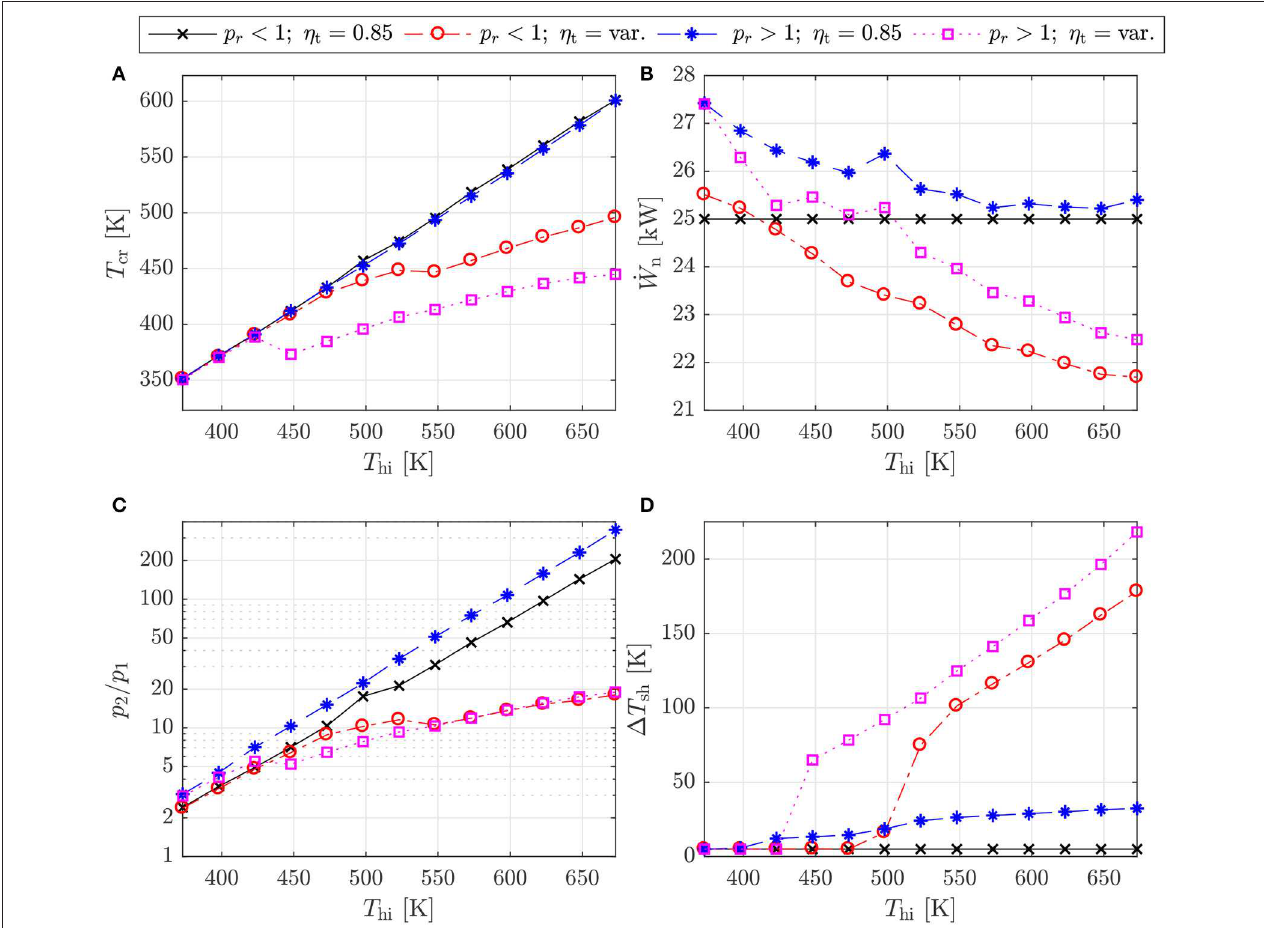
FIGURE 6 | Optimal subcritical ( p r < 1) and transcritical ( p r > 1) cycles for different heat-source temperatures obtained using a fixed turbine efficiency ( η t = 0.85) and the variable efficiency model ( η t = var.): (A) Optimal critical temperatures; (B) net power output; (C) cycle pressure ratio; and (D) amount of superheat.